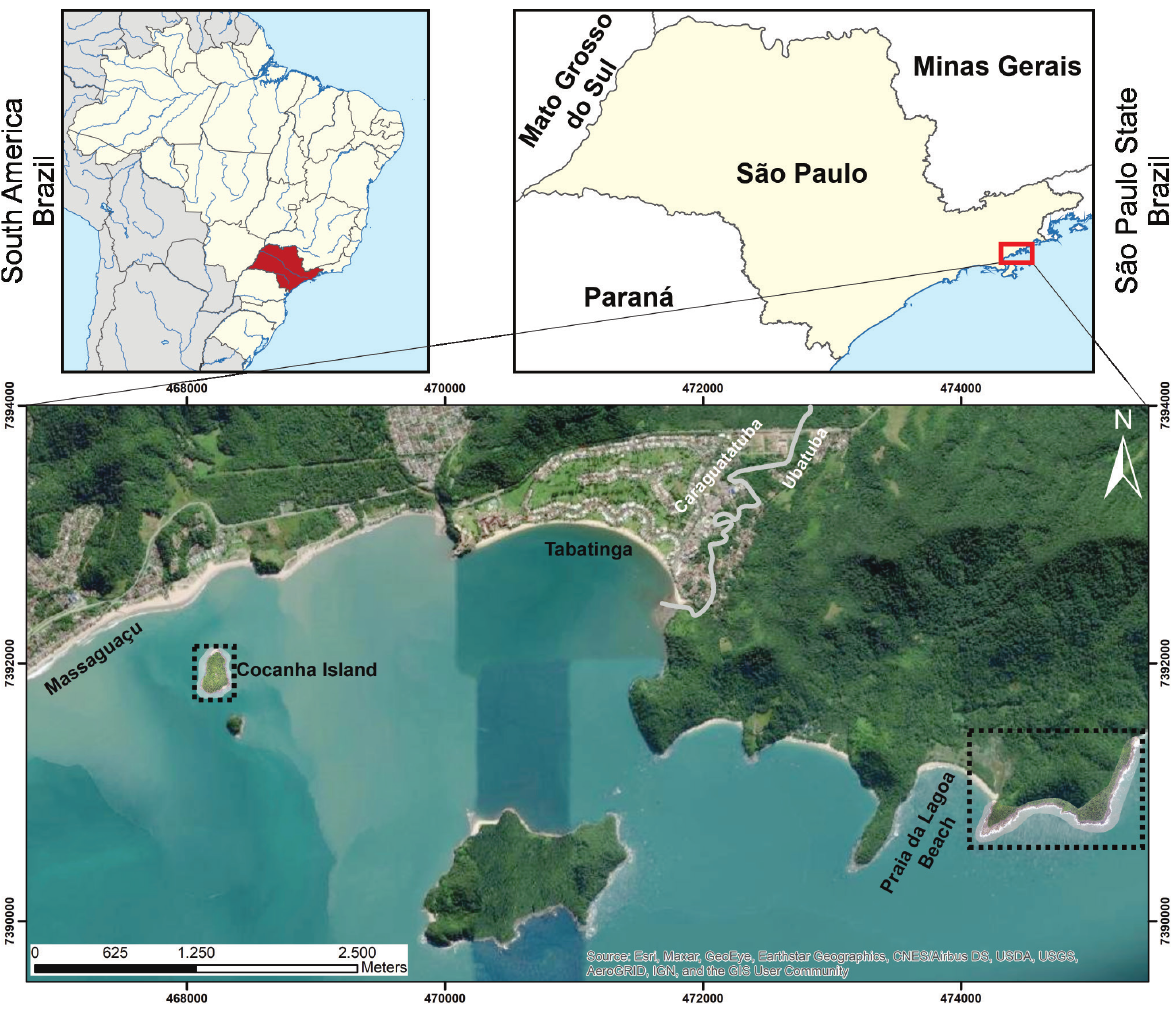
Figure 1. Location of the two studied areas in Caraguatatuba and Ubatuba municipalities, northern coast of São Paulo State. The studied areas are indicated with dashed rectangles - Cocanha Island (Caraguatatuba municipality) and Praia da Lagoa Beach rocky shore (Ubatuba municipality). The gray line indicates the municipal limits between Caraguatatuba and Ubatuba